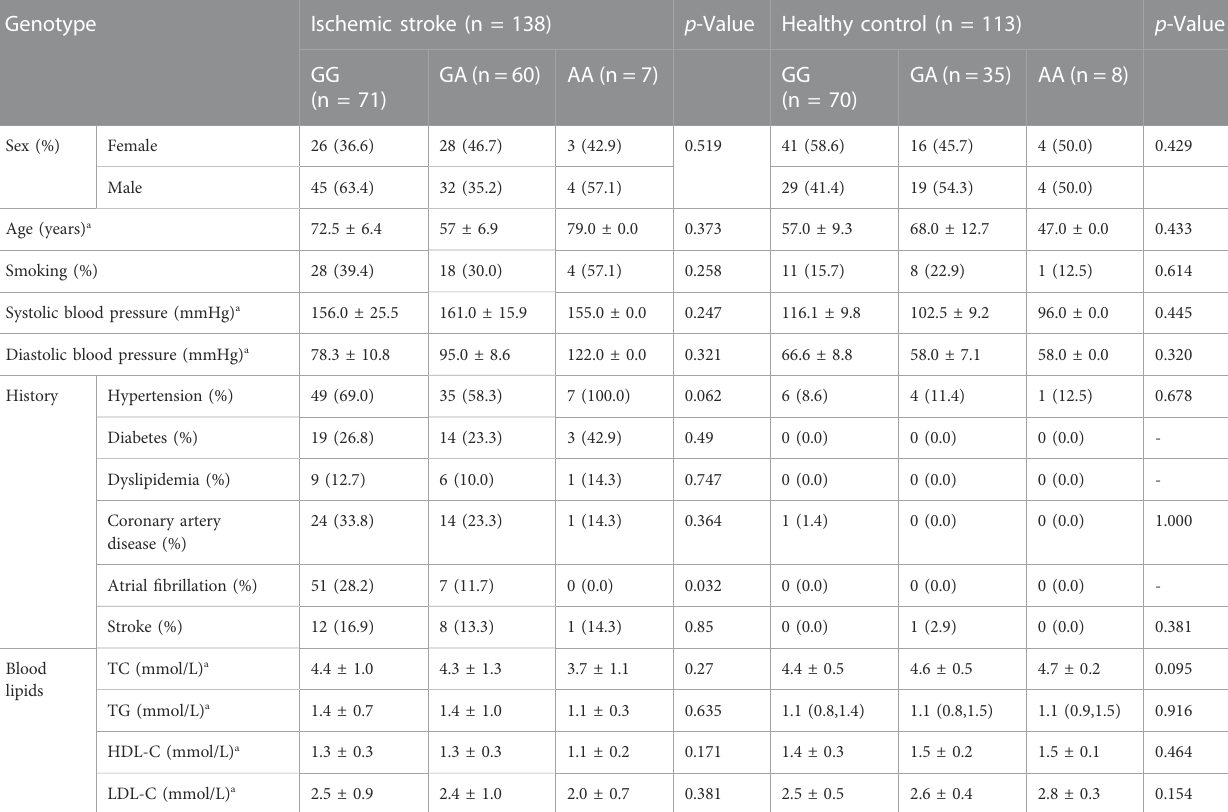
TABLE 4 Association between different FABP2 genotype and risk factors for ischemic stroke. Genotype Ischemic stroke (n =